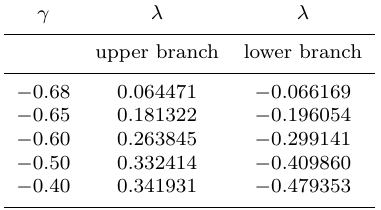
Table 2. The smallest eigenvalue λ for several values of γ < 0 when S = 1.